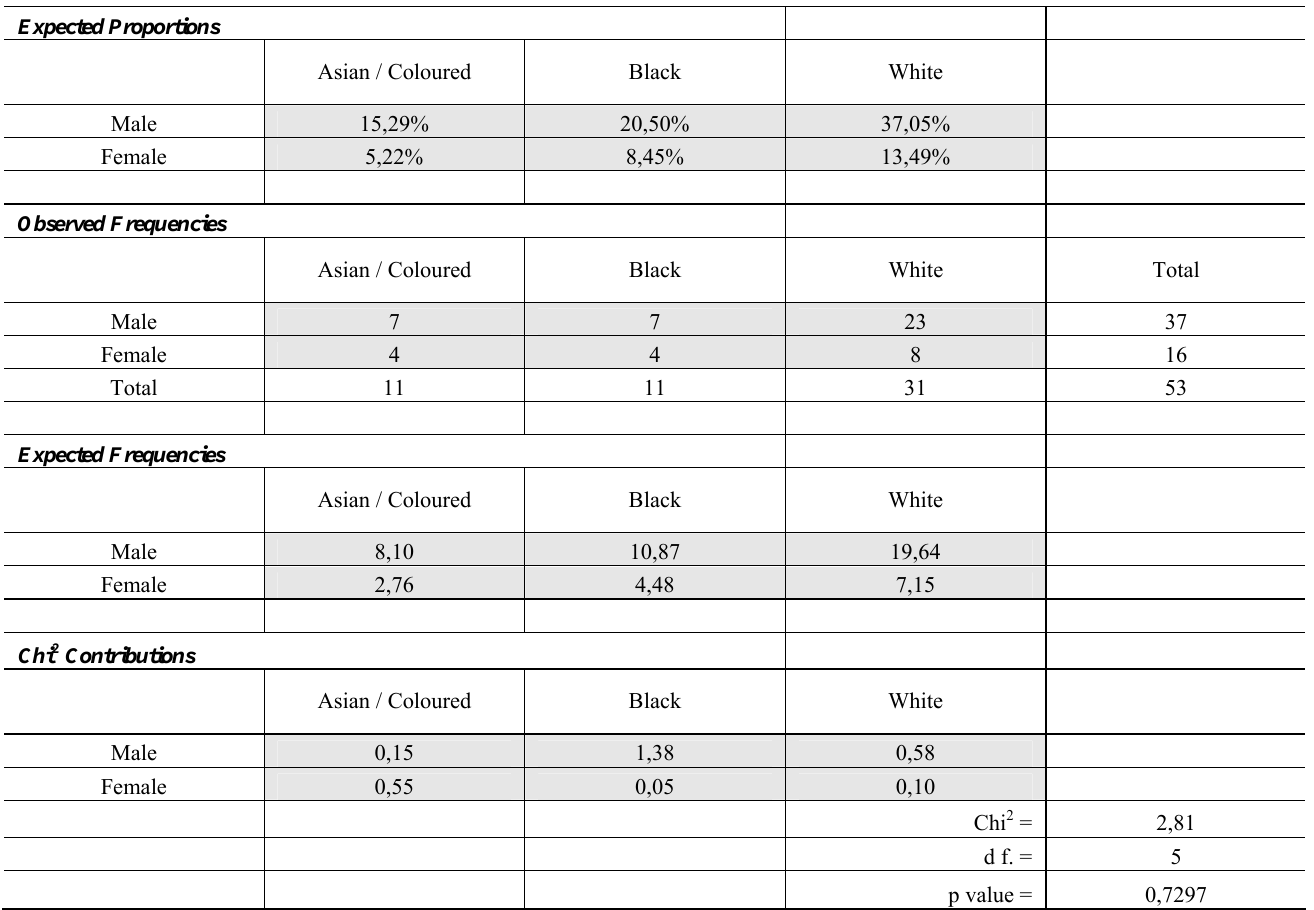
Table 2: The demographic variables of the respondents and Chi 2 calculation Expected